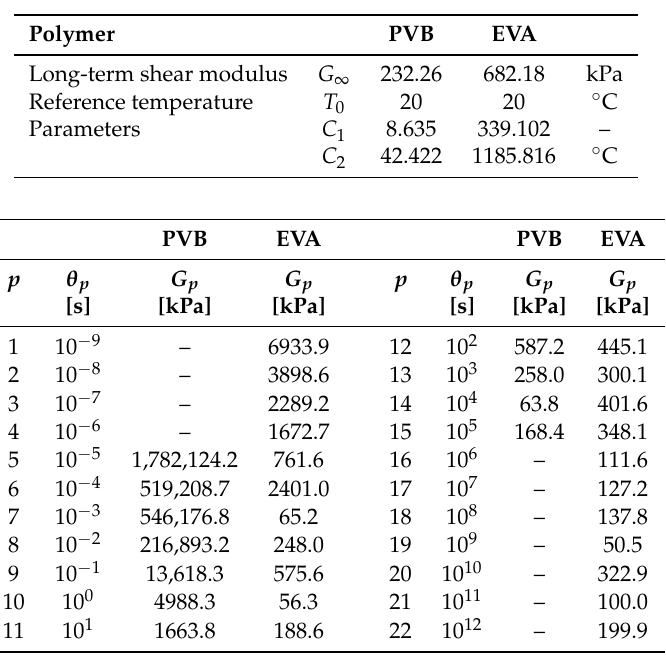
Table 1. Parameters for the generalized Maxwell model for PVB (TROSIFOL ® BG R20) and EVA interlayers (EVALAM